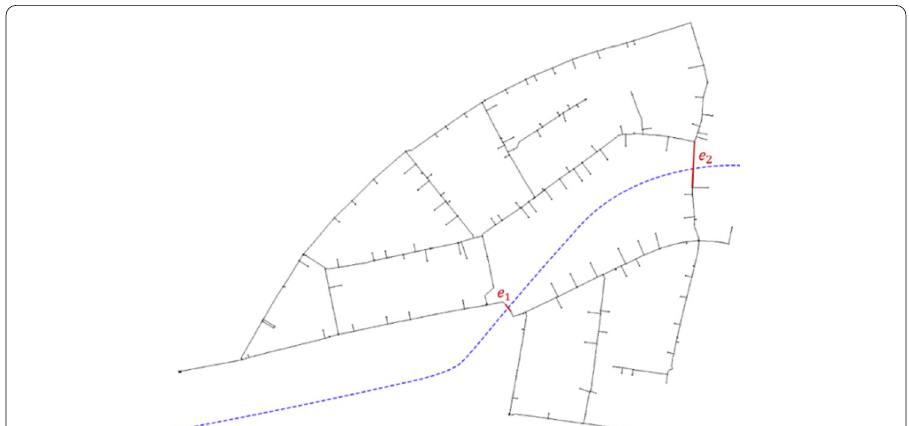
Fig. 4 Neptun WDN (clustering with K